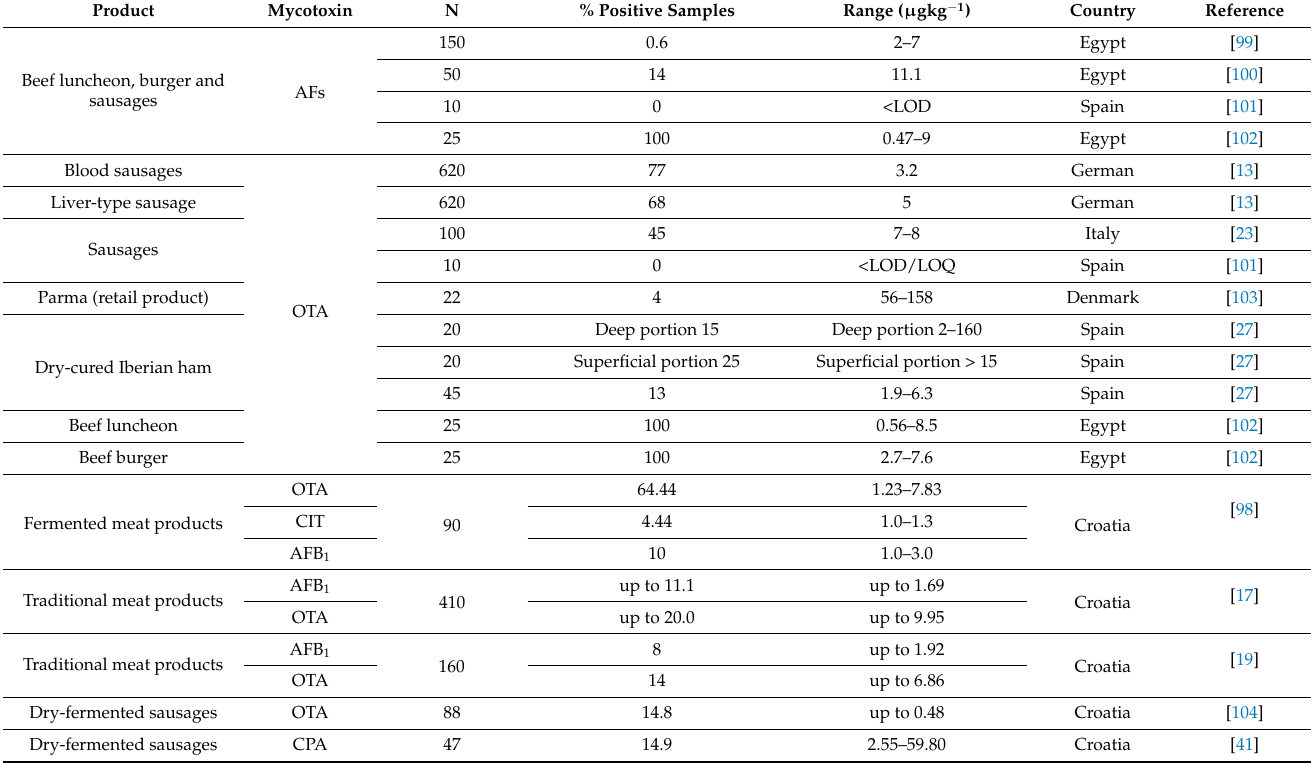
Table 2. The worldwide occurrence of mycotoxins in meat